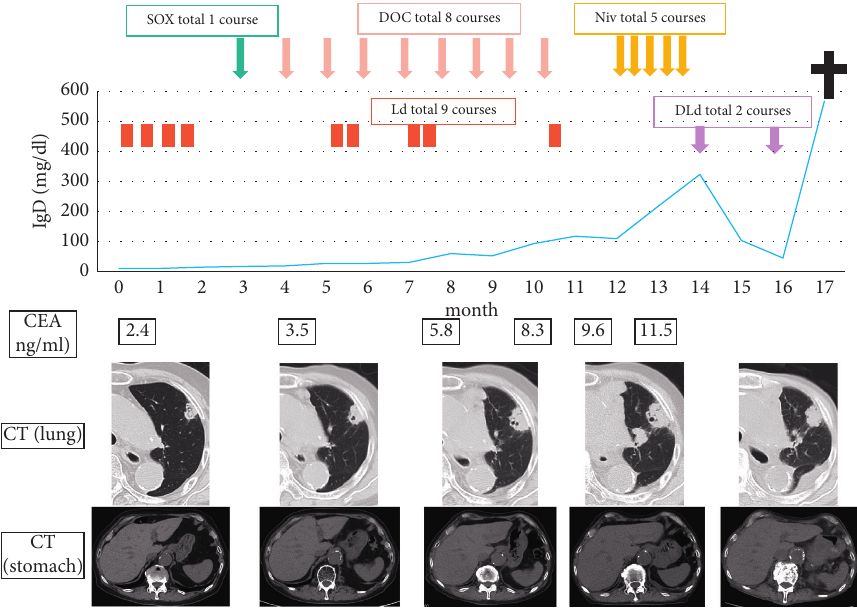
Figure 2: Clinical courses of the patient after gastric and lung cancers are diagnosed. The solid line indicates serum IgD level. Computed tomography (CT) shows the lung nodules and stomach. At the time of appearance, a pulmonary nodule with a diameter of 20mm is found in the upper lobe of the left lung. The tumor grew over time, and a new intrapulmonary lesion appears after DOC treatment, but after nivolumab treatment, the new lesion almost disappeared and the primary lesion reduced. The gastric cancer could not be identified by CTat the start of treatment and had not changed since then. But 16 months after, gastric cancer increased. SOX: tegafur, gimeracil, oteracil potassium (TS-1), and oxaliplatin; DOC: docetaxel; Niv: nivolumab; Ld: lenalidomide and dexamethasone; DLd: daratumumab, lenali- domide, and dexamethasone, CEA: carcinoembryonic